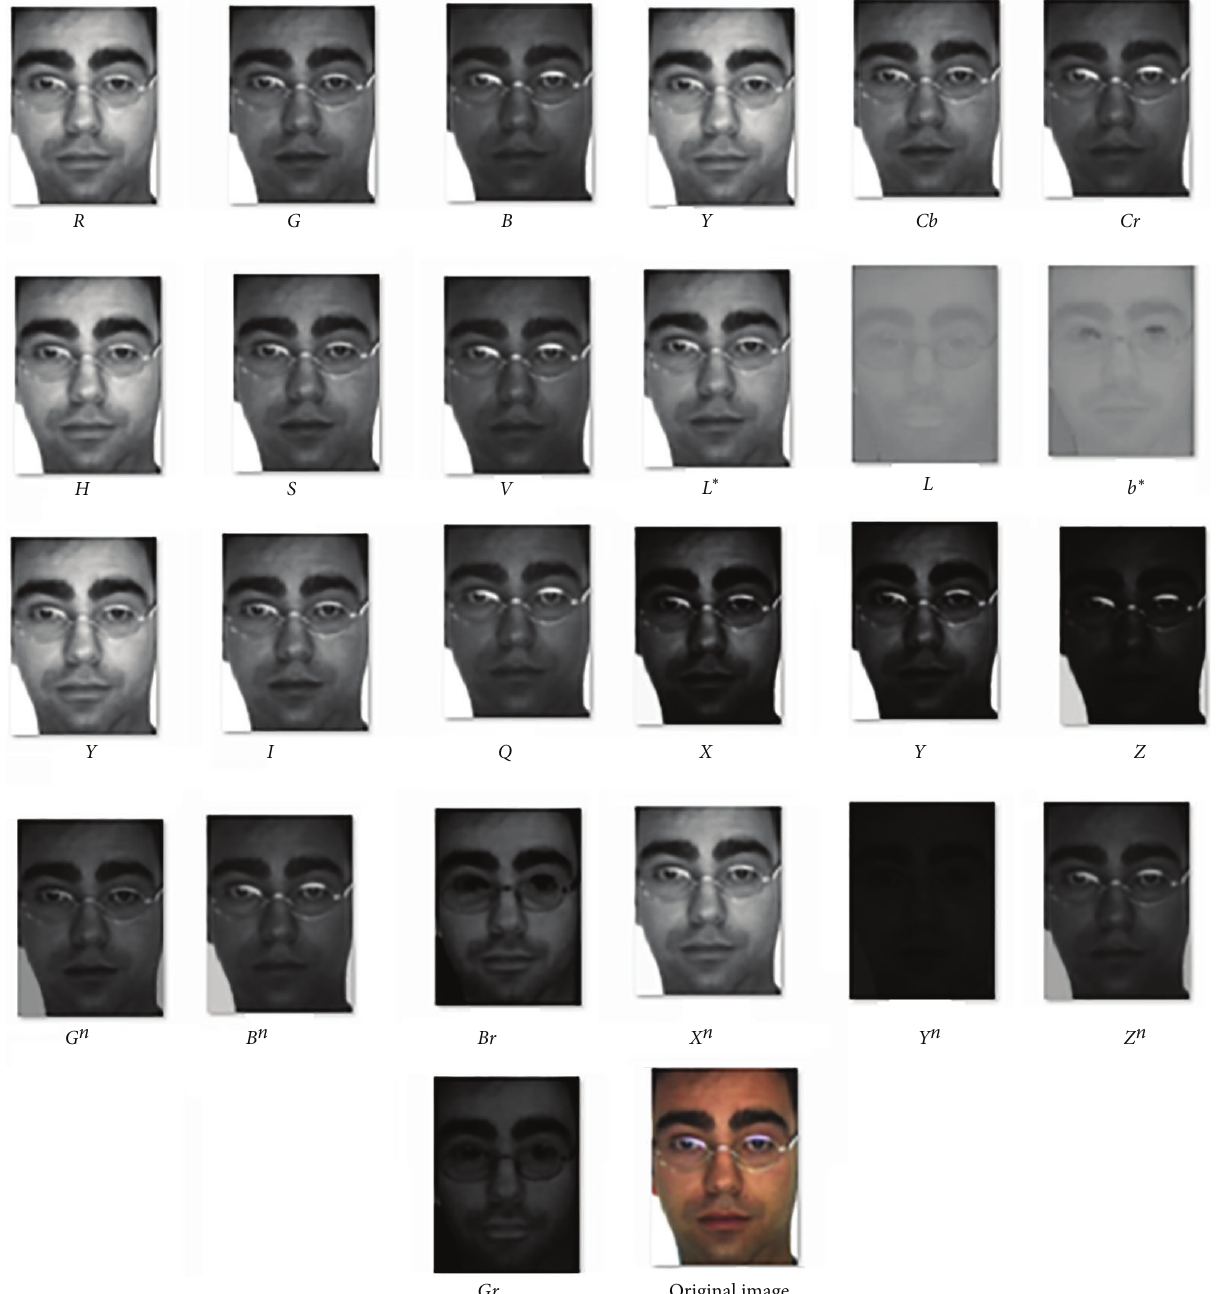
Figure 6: A subject of the AR database and its color component